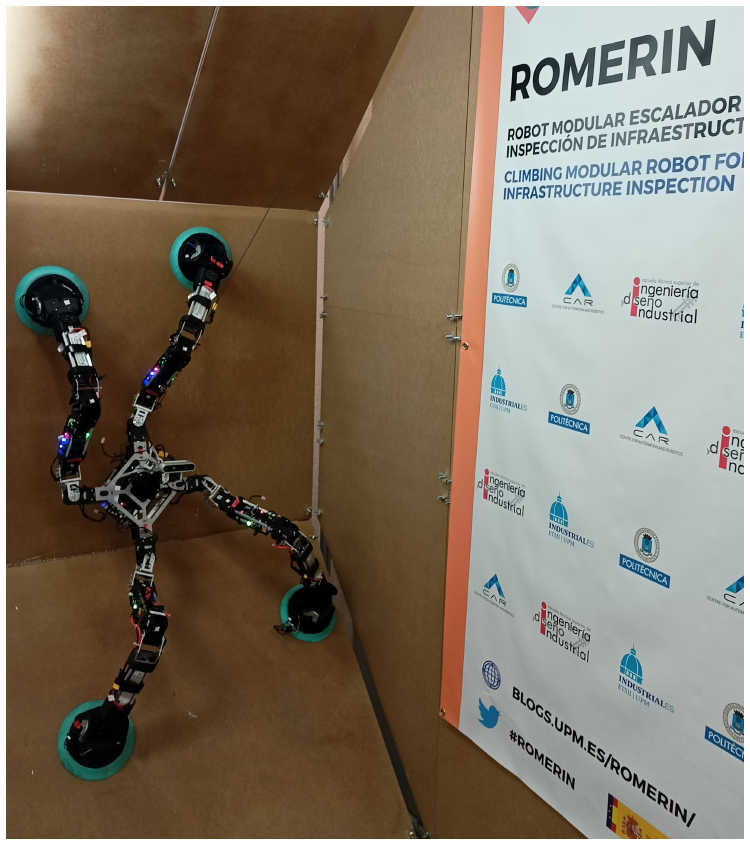
Figure 1. The ROMERIN robotic organism on vertical